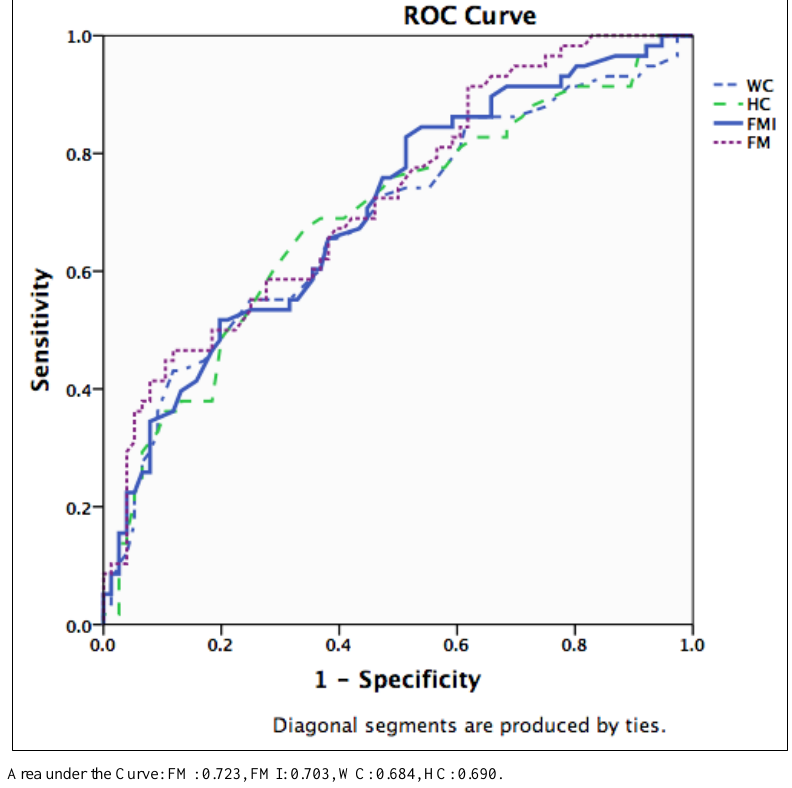
Figure 2. ROC curve analysis of fat mass, fat mass index and indirect methods according to metabolic